Question: Summarize what this figure shows in one sentence.
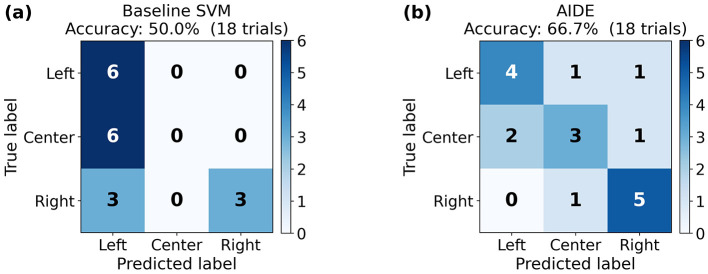
Answer: Online test confusion matrices for (a) baseline model and (b) AIDE. Each matrix shows the number of trials for each true/predicted class combination. The AIDE model achieves higher diagonal values, indicating improved real-time accuracy.